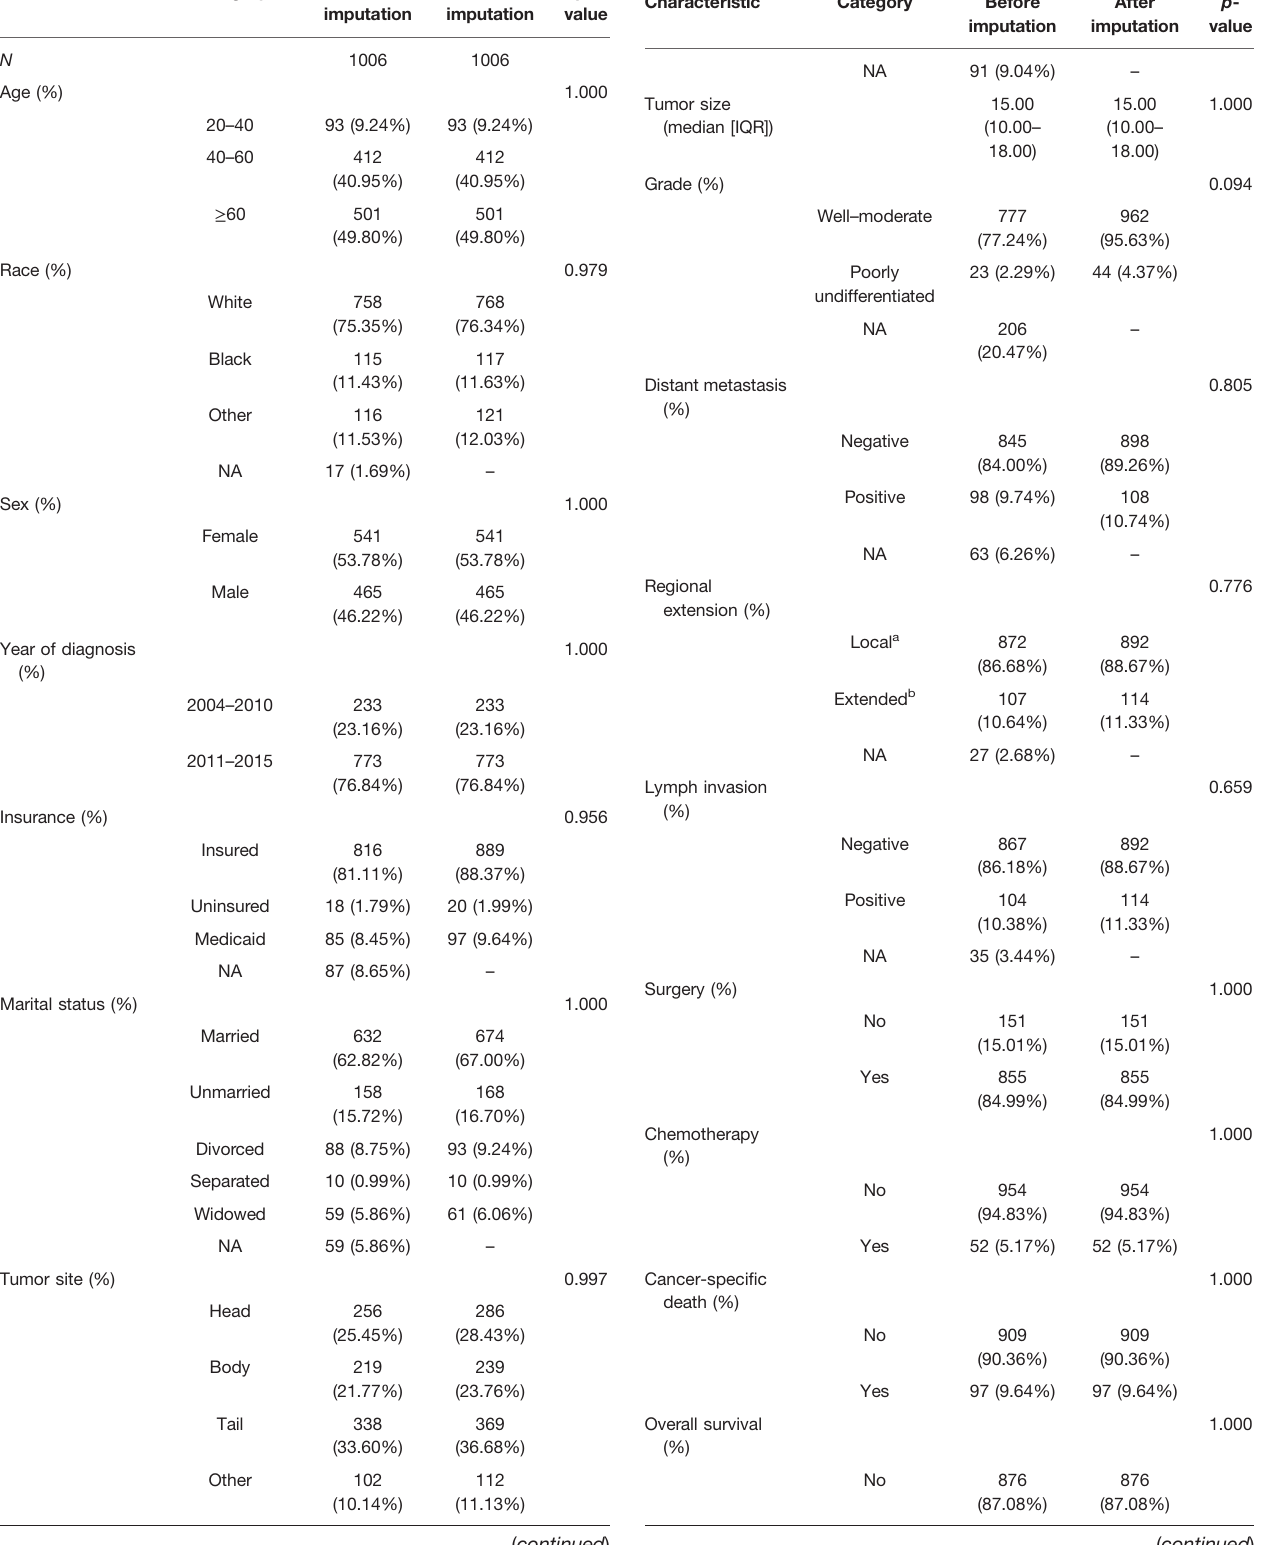
TABLE 1 | Patient